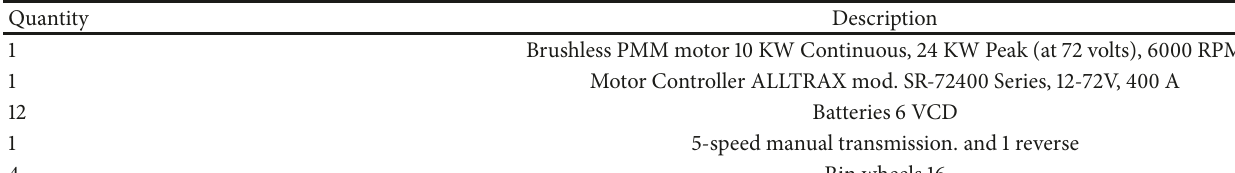
Table 1: Description of the original EV components.